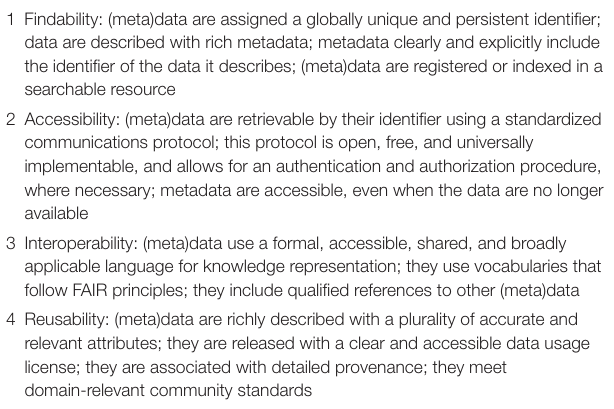
TABLE 1 | FAIR principles for data management and